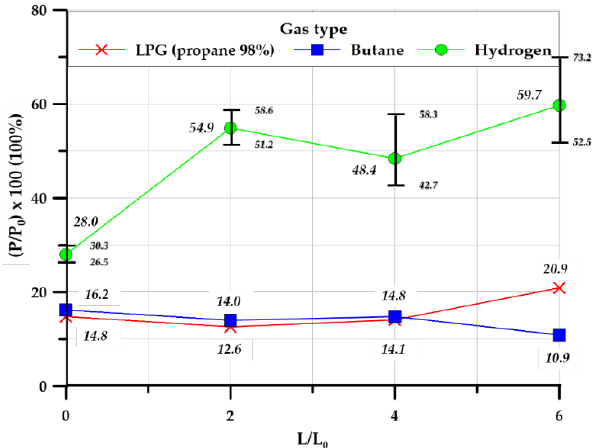
Figure 10. Pressure ratio (P/P 0 , %) in the cylinder-type chamber.